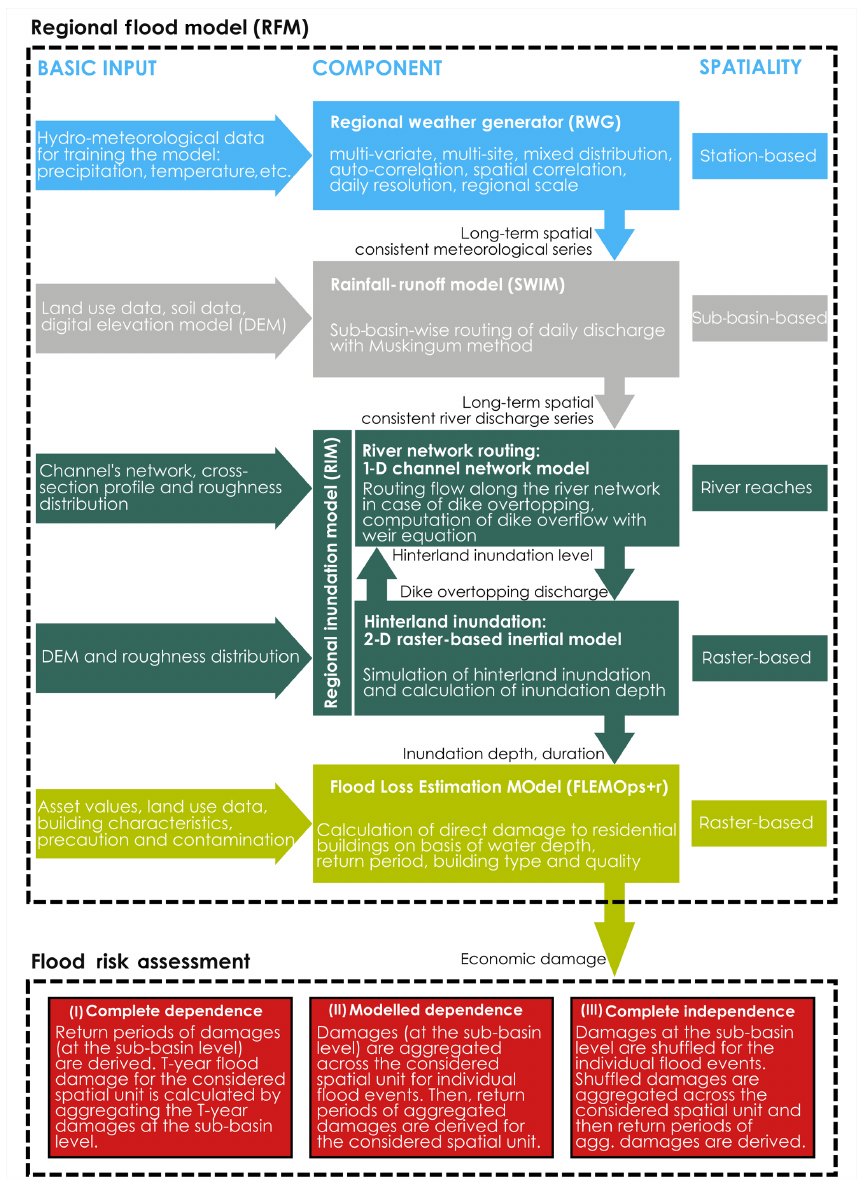
Figure 2. Workflow for the derived flood risk assessment (DFRA) with the regional flood model